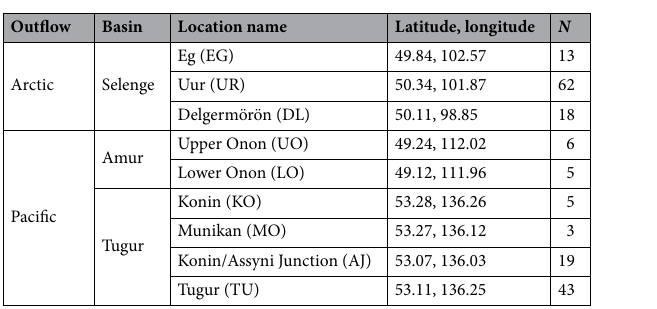
Table 1. Geographic locations, sample sizes, and capture information for taimen analyzed in this study. Site abbreviations correspond to those in Figs. 1 and